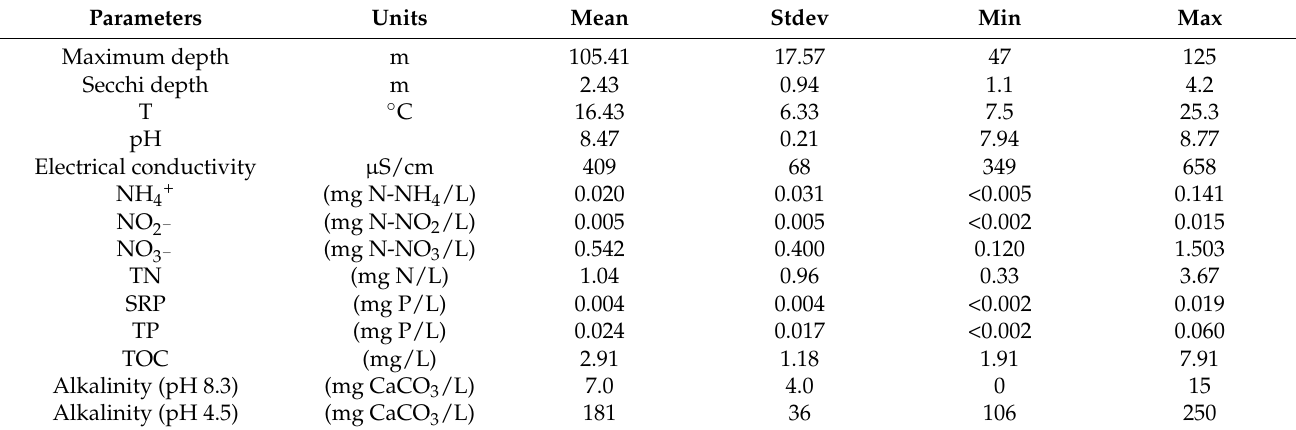
Table 3. Summary statistics of environmental and chemical parameters in the Moglicë Reservoir.